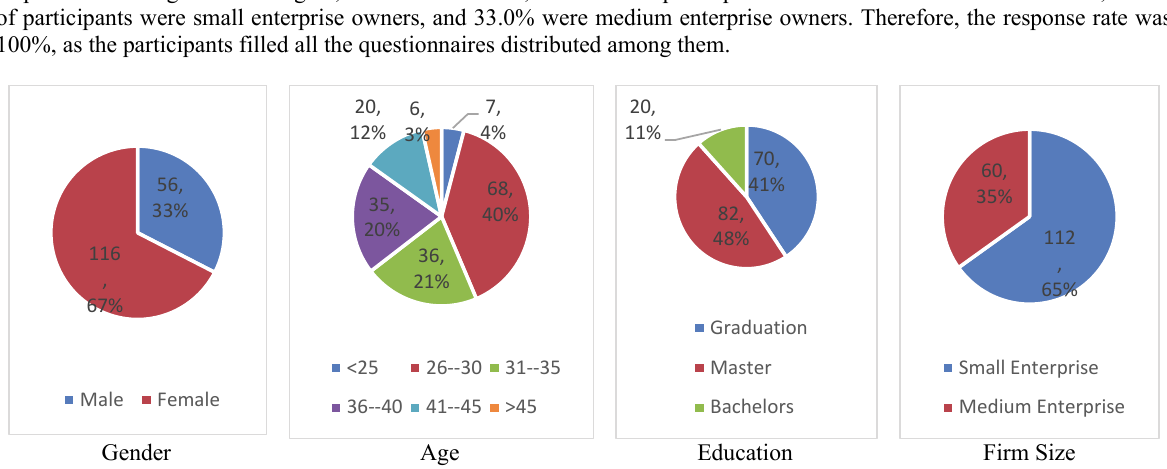
Fig. 5. Demographical Data of the Study Respondents